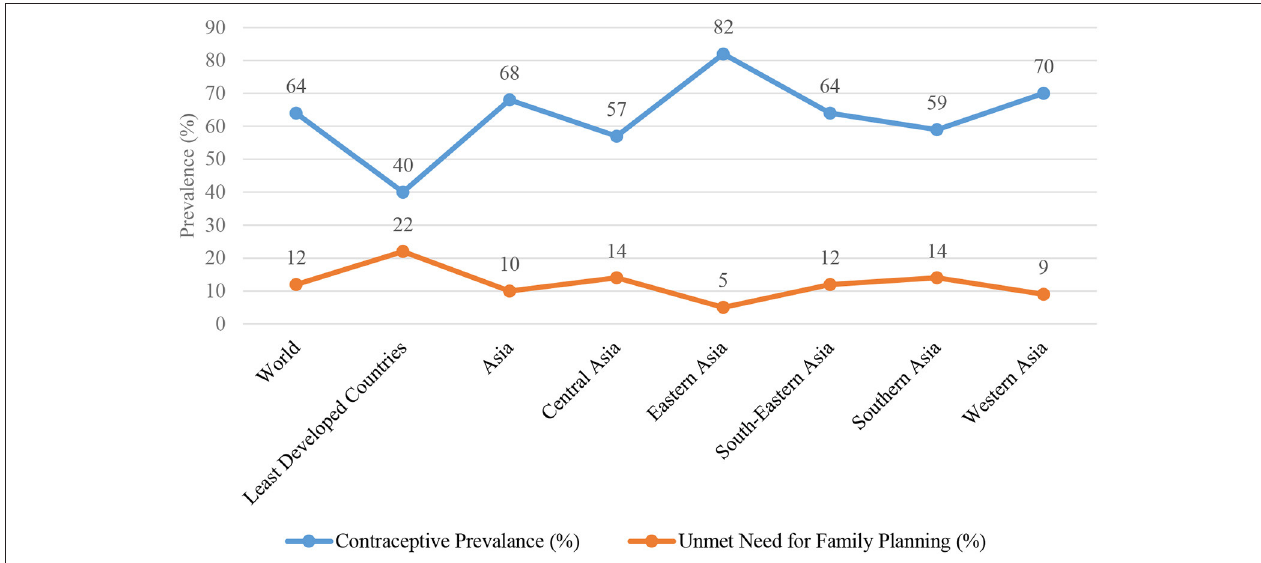
FIGURE 4 | Contraceptive prevalance and unmet need for family planning among married or in-union women aged 15–49 years, 2015 [Source: United Nations (25)].